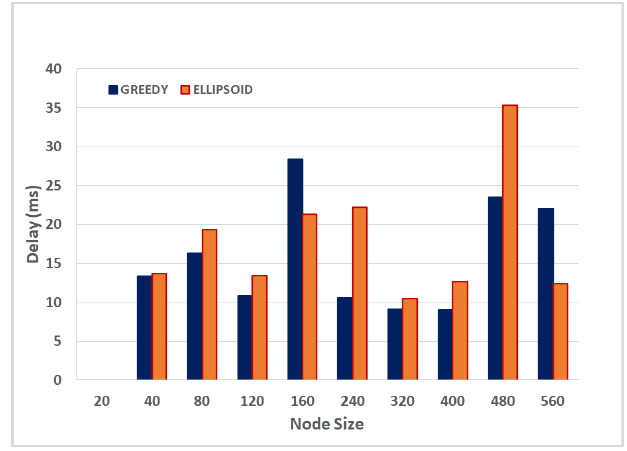
Figure 8. Average hop count (MANET case)